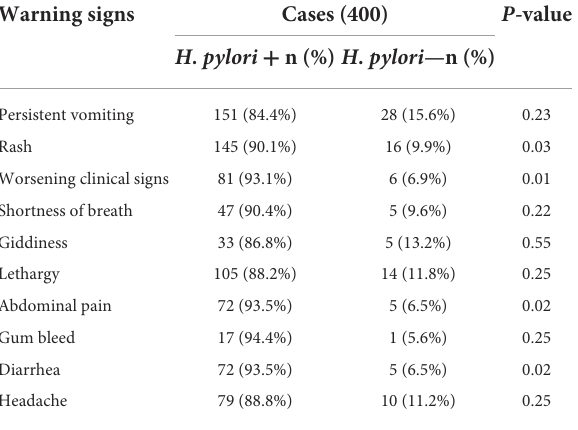
TABLE 2 Warning signs of dengue fever in H. pylori + and H. pylori— groups. Warning signs